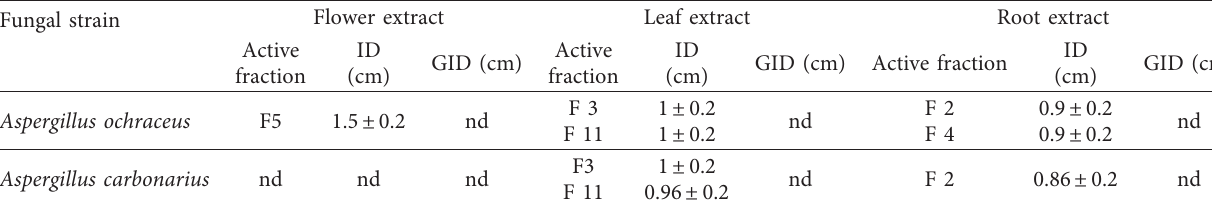
Table 6: Antifungal activities.